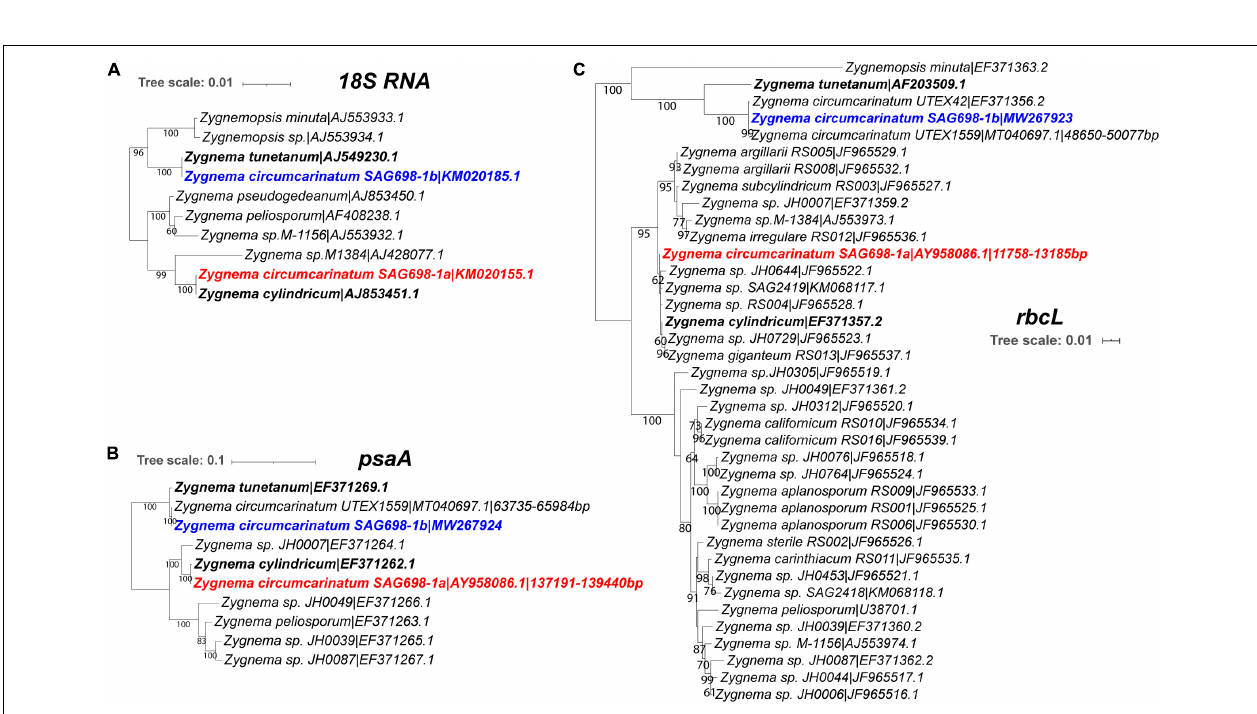
FIGURE 4 | Maximum-likelihood phylogenetic trees of (A) 18S rRNA, (B) rbcL , and (C) psaA sequences. The detailed method to build these trees are described in Methods. Each sequence has its label including species name and GenBank accession numbers. For SAG 698-1a and UTEX 1559, when the RNA sequences are not available, their plastome accession numbers are provided instead with the positions of the genes indicated. For SAG 698-1b, its rbcL (MW267923) and psaA (MW267924) mRNA sequences are sequenced in this study and submitted to GenBank.